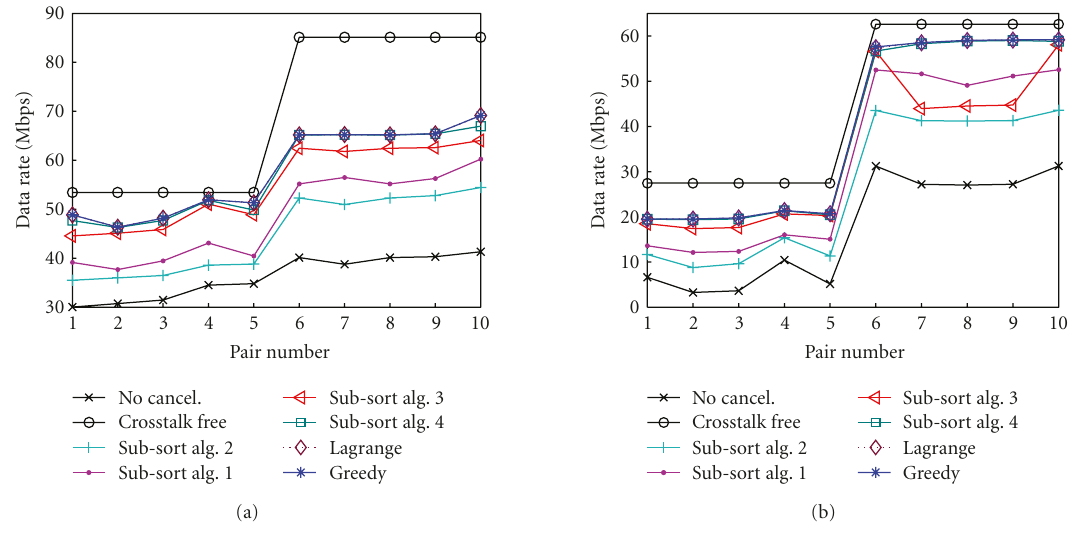
Figure 7: Data rates for proposed JTLS algorithms compared to the optimal solution for near-far Scenario 2 (pairs 1 to 5: 600m, pairs 6 to 10: 300m): (a) downstream ( p = 4) and (b) upstream ( p =